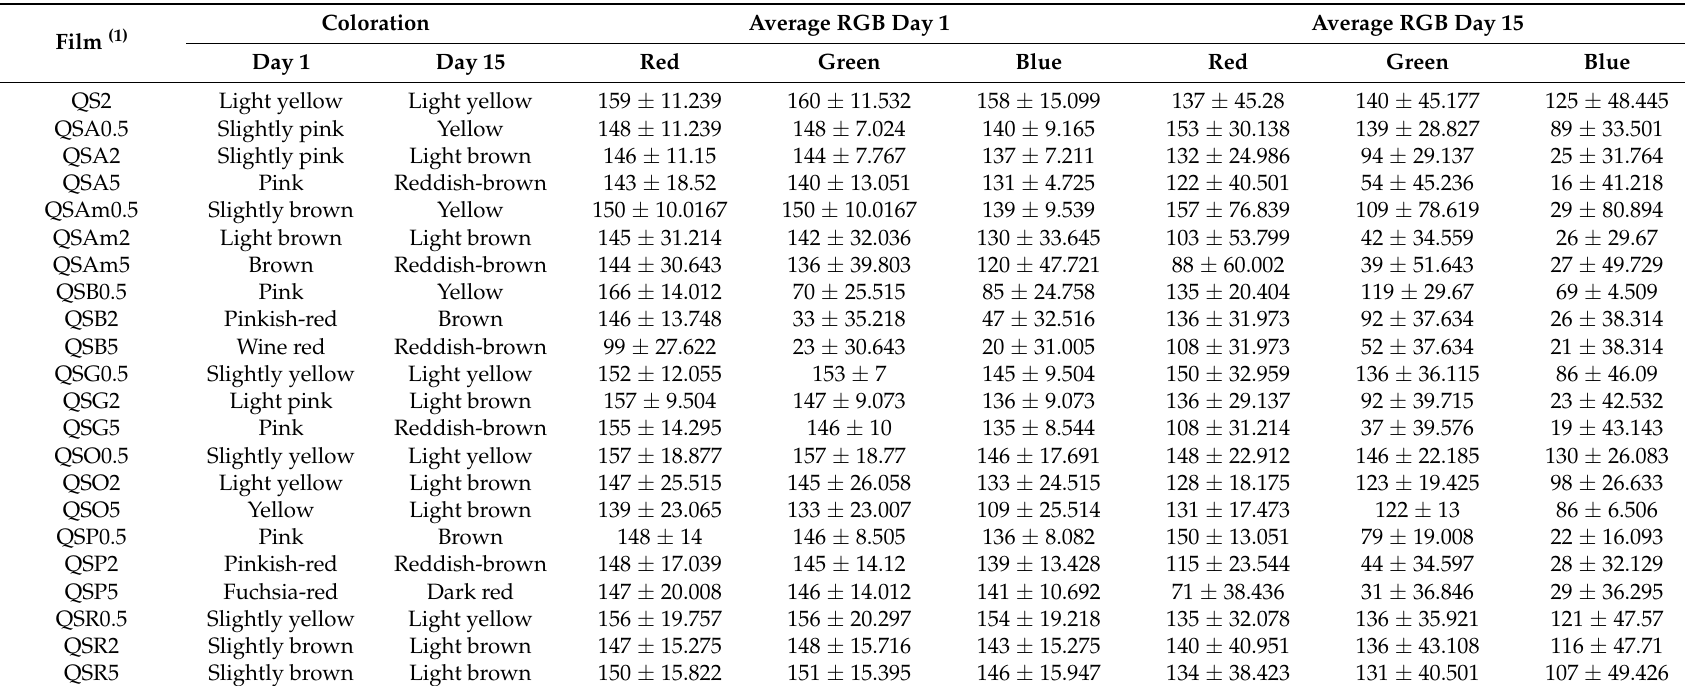
Table 1. Visual evaluation of film coloration and average RGB values at day 1 and